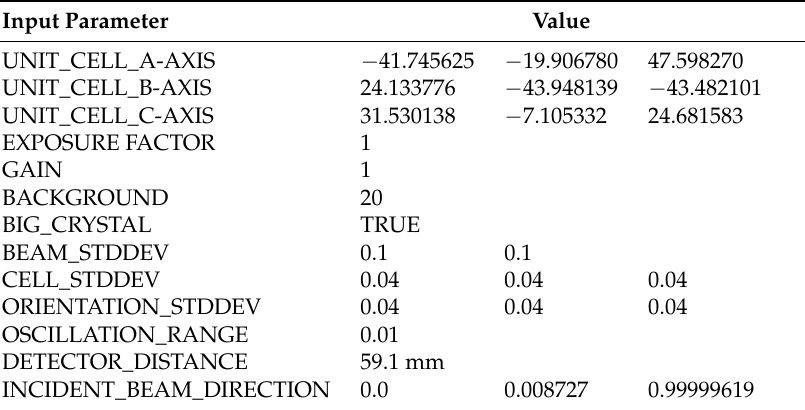
Figure 8. Comparison of the time/energy streaking in space in the same reflections at two different chirps (top panels against bottom panels). Reflections are labeled with their Miller indices. Table 1. Input parameters for SIM-MX